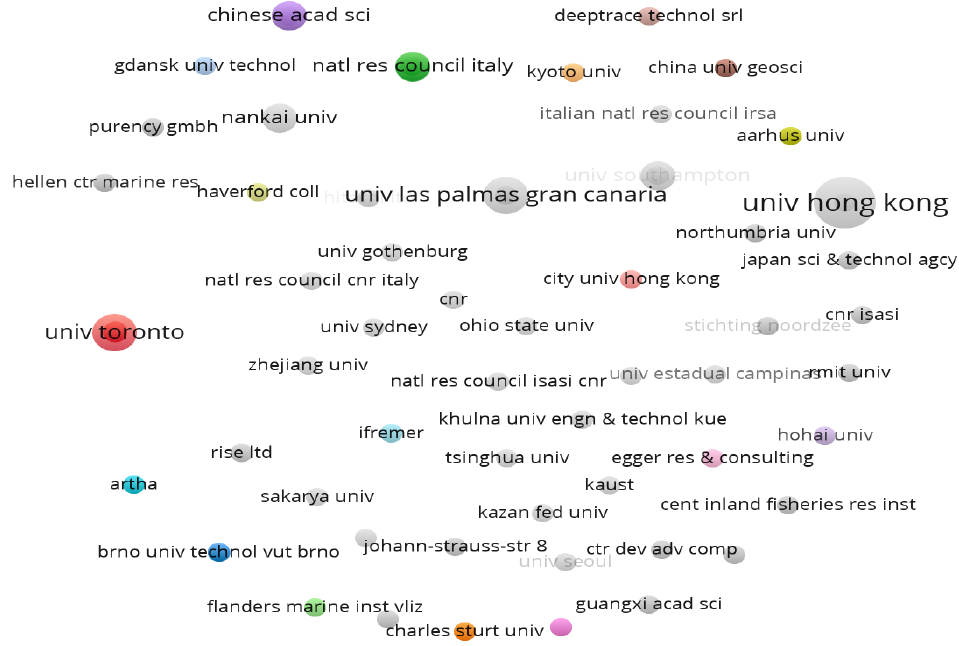
Figure 10. Collaboration networks of all 133 institutes (visualized with VOSviewer).